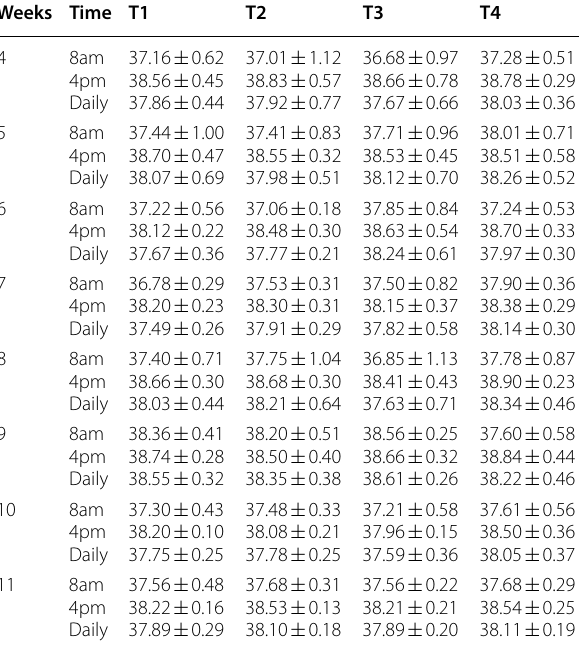
T1 control, T2 ascorbic acid, T3 sodium bicarbonate, T4 ascorbic acid a , b , c means within a row with different superscript are significantly different ( p < 0.05)